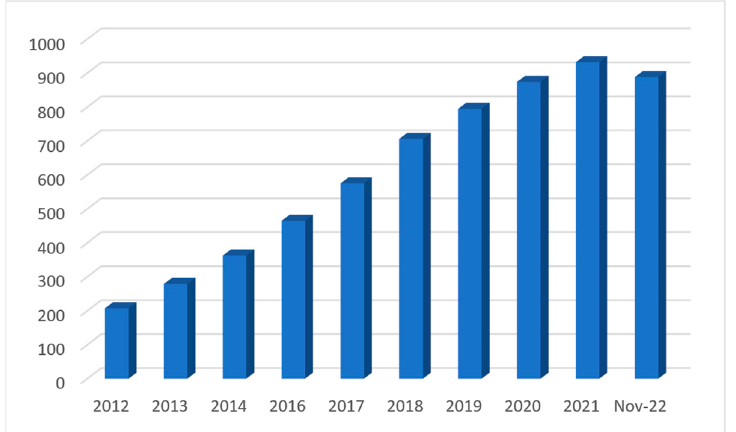
Figure 1. Annual publications in advanced search for CPEPS sector (Source: Google Scholar).